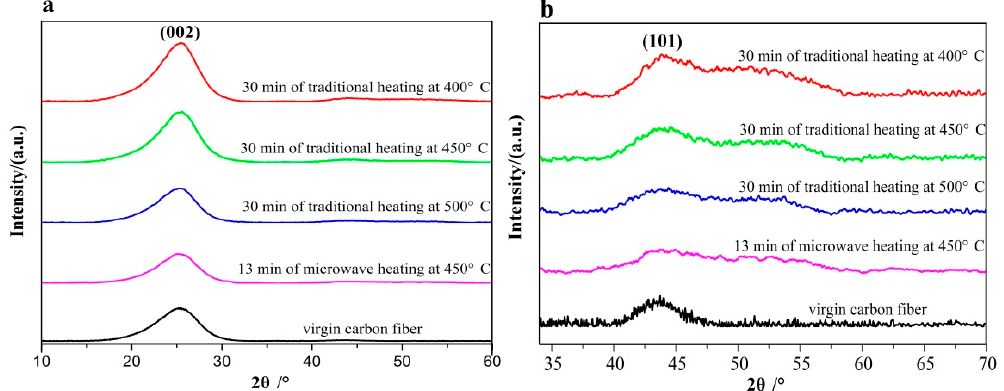
Figure 7. ( a ) XRD spectra of the (002) plane of carbon fibers, ( b ) XRD spectra of the (101) plane of carbon fibers.